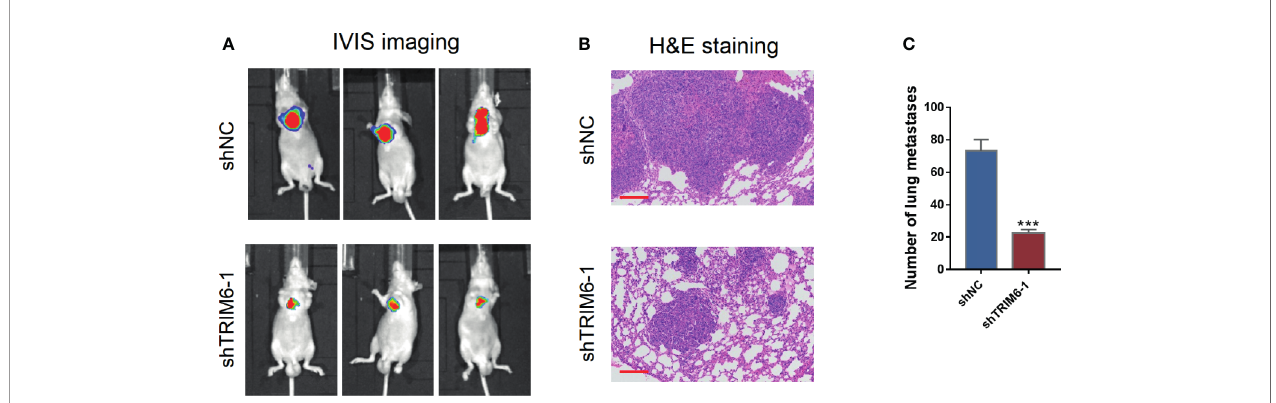
FIGURE 2 | TRIM6 knockdown inhibits CRC lung metastasis in mice injected with HCT116 cells. (A) Representative bioluminescent images of mice (n = 5 per group) injected with the indicated cells taken at day 28. (B) Hematoxylin and eosin (H&E)-stained sections revealed that tumor cells metastasized to the alveoli of the lung in mice injected with the indicated cells. Scale bar: 200 µm. (C) Number of lung metastases. ***P < 0.001